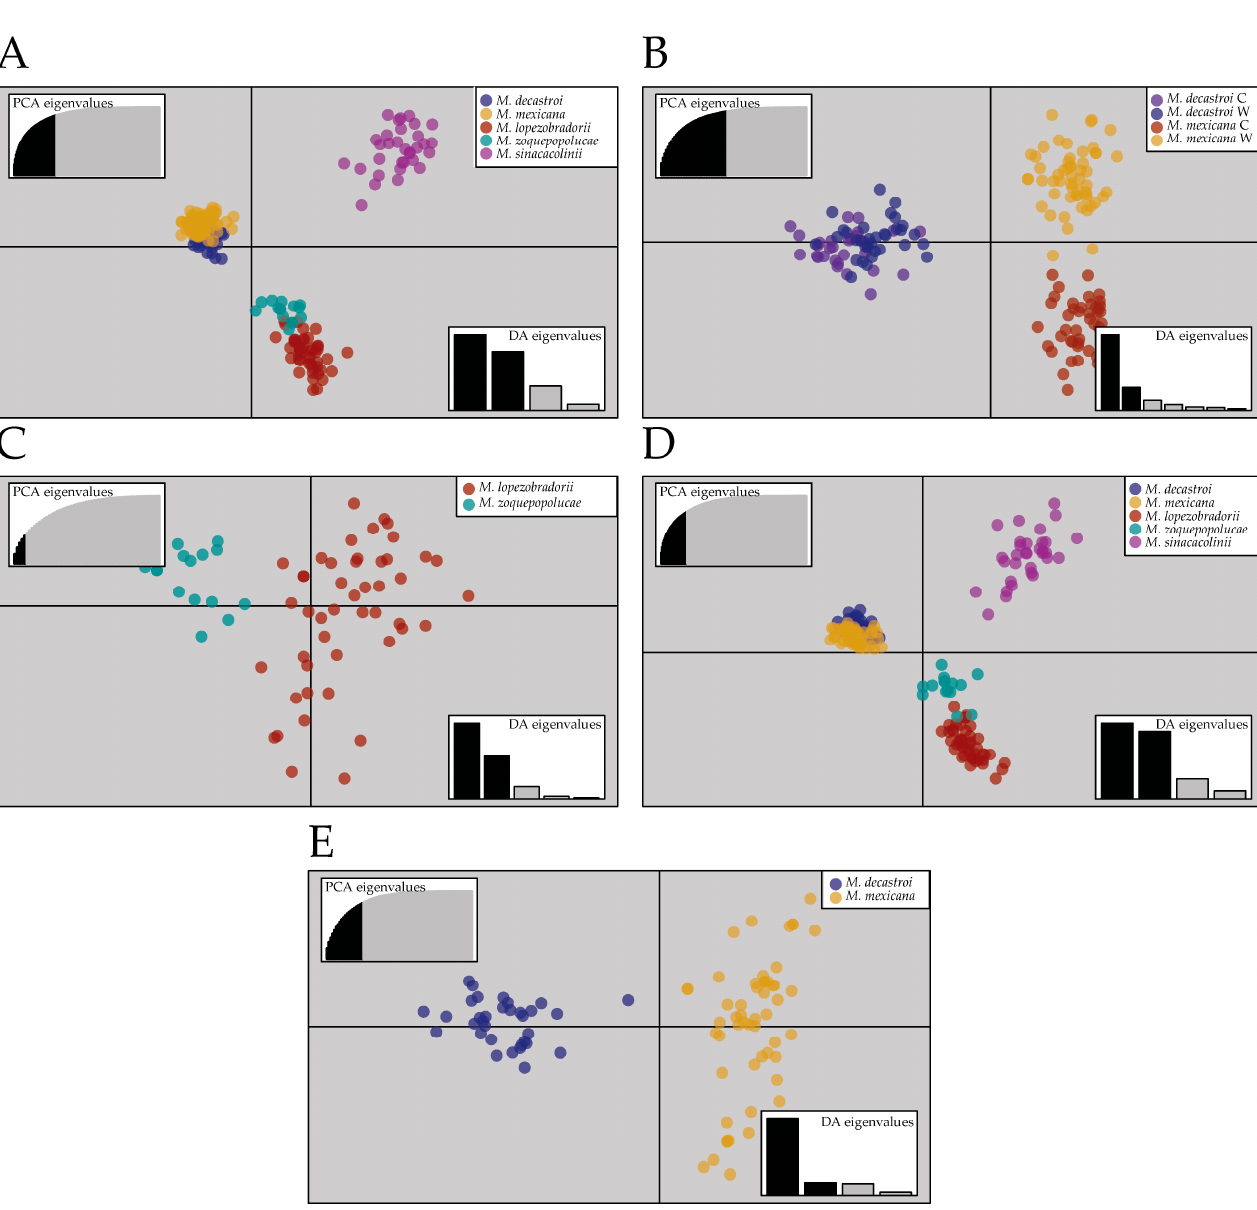
Figure 4. Discriminant Analysis of Principal Components (DAPC) of Magnolia sect. Talauma individuals in Puebla and Veracruz, Mexico. The axes represent the first two linear discriminants. The upper left graph (principal component analysis (PCA) eigenvalues) inset displays the variance explained by the principal component axes used for DAPC and the bottom-right inset (DA eigenvalues) displays in relative magnitude the variance explained by the two discriminant axes plotted. ( A ) DAPC graph of the complete dataset analysis, 150 principal components (PCs) retained. ( B ) DAPC graph of the M. decastroi and M. mexicana localities, 50 PCs retained. ( C ) . DAPC graph of the M. lopezobradorii and M. zoquepopolucae localities, 5 PCs retained. ( D ) DAPC graph of the wild dataset, 150 PCs retained. ( E ) DAPC graph of the M. decastroi and M. mexicana wild localities, 60 PCs retained.